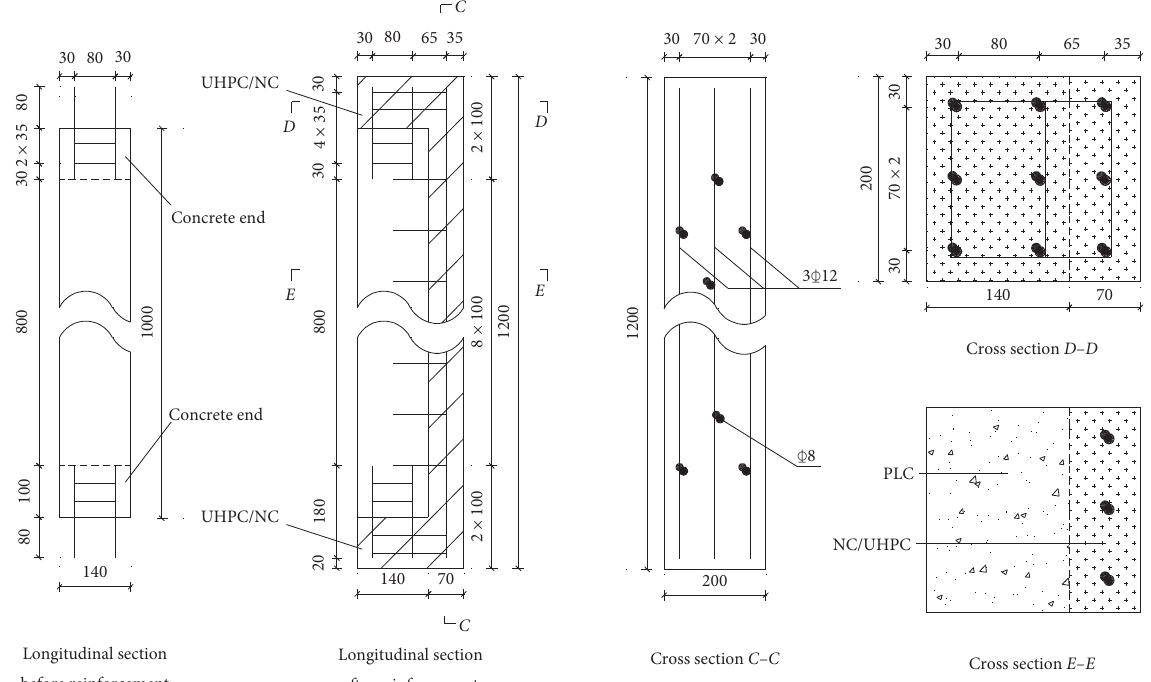
Figure 2: The details of the specimen with a 70 mm reinforcement